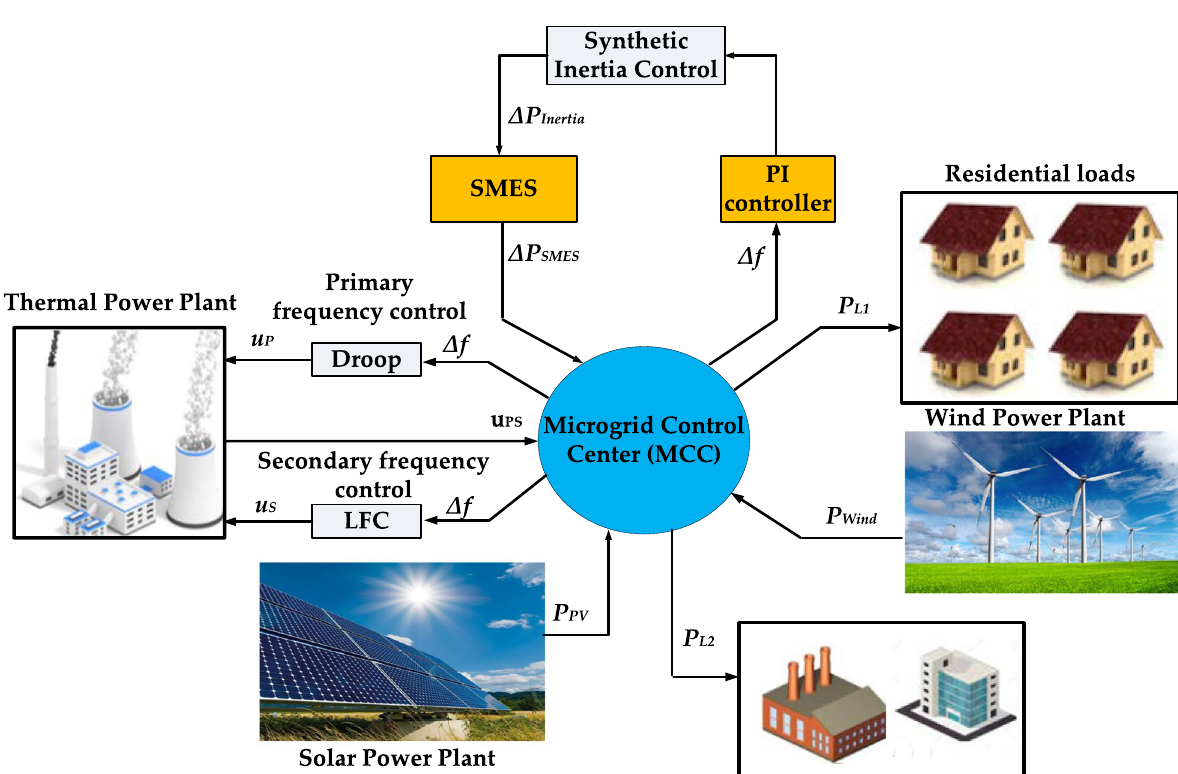
Fig. 1 A simplified scheme of the islanded µG with the proposed SMES-based SIC